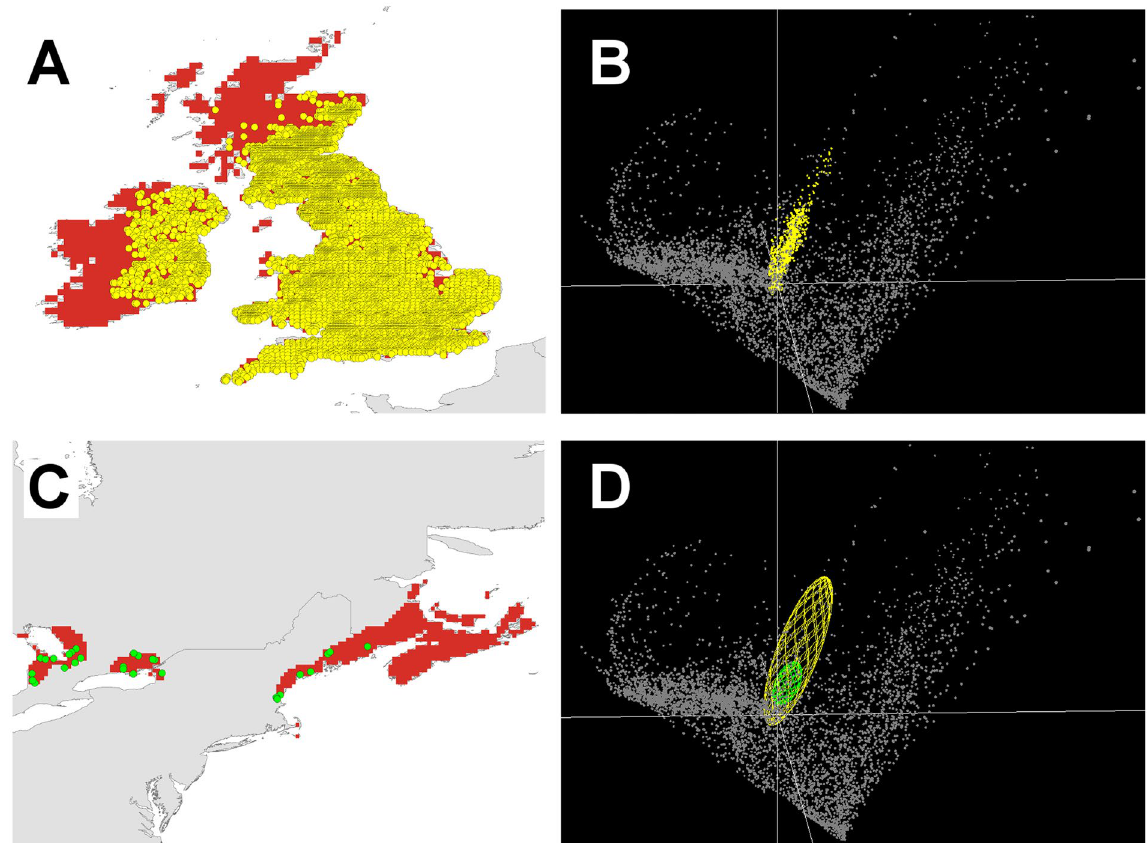
Figure 3. Gray Squirrel distribution. ( A ) Occurrences in geographic space (yellow points) in invaded areas (red). ( B ) Display in environmental space of corresponding occurrences from invaded areas (yellow points). ( C ) Geographic occurrences (green points) in the native range, restricted to areas with environments analogous between native and invaded range (red). ( D ) Display in environmental space of models from occurrences in the native (green ellipsoid) and invaded ranges (yellow ellipsoid) falling in environments analogous between native and invaded range. Notice the occurrences from native areas (green ellipsoid) nested within the ellipsoid corresponding to occurrences from the invaded areas (yellow ellipsoid) in the environmental space ( D ). Background values are show as gray. Left figures done using ArcGIS 10.2 (ESRI, Redlands, CA, http://www.esri. com/) and right figures done using NicheA 3.0 [ref. 48].